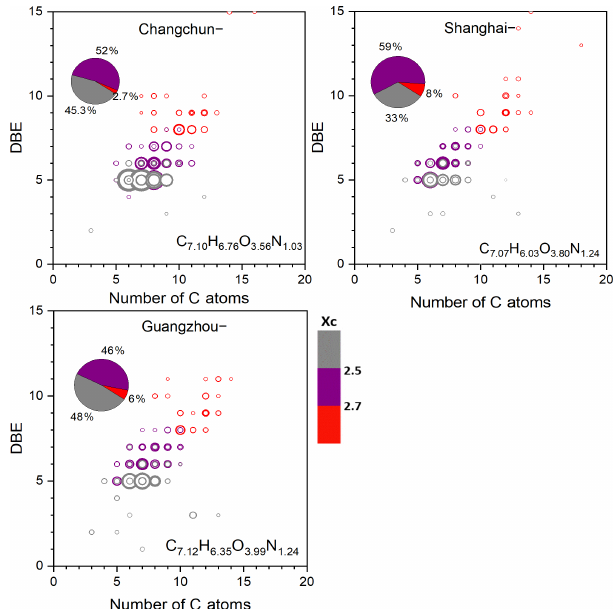
Figure 5. Double bond equivalent (DBE) versus carbon number for all CHON- compounds for all sample locations. The molecu- lar formula represents the abundance-weighted average CHON- for- mula, and the area of circles is proportional to the fourth root of the peak abundance of an individual compound (a diagram with circle areas related to absolute peak abundances is presented in Fig. S6). The color bar denotes the aromaticity equivalent (gray with X C < 2 . 50, purple with 2 . 50 ≤ X C < 2 . 70 and red with X C ≥ 2 . 70). The pie charts show the percentage of each X C category (i.e., gray color- coded compounds, purple color-coded compounds and red color- coded compounds) in each sample in terms of peak